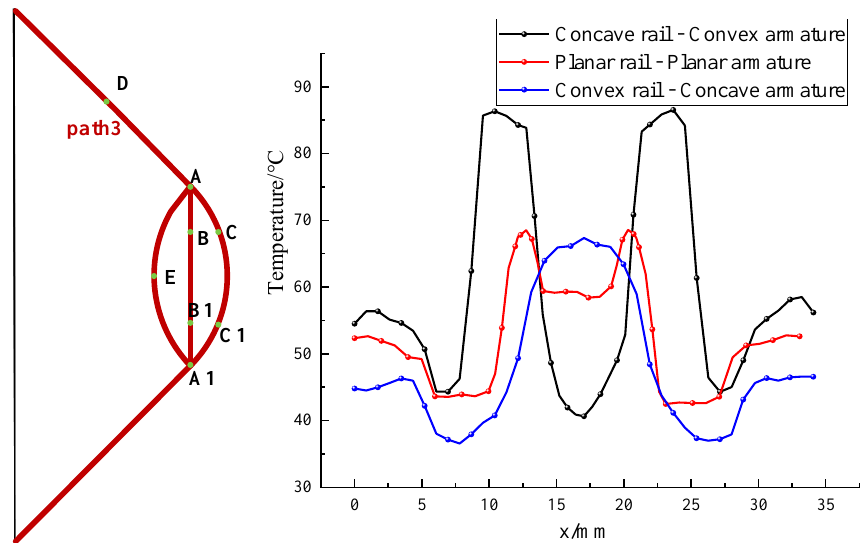
FIGURE 11. Schematic diagram of path 3 and temperature distribution From the above cross-sectional diagrams, it can be learned that the maximum temperatures at the trailing part of the rails of three configurations of electromagnetic launchers, namely, concave-rail-convex armature, planar- rail-plane armature and convex-rail-concave armature, are 61.52°C, 59.79°C and 52.11°C, respectively. The Joule heat on the orbits of the three configurations is mainly concentrated at the edge of the orbit, which is caused by the skinning effect and proximity effect of the current. The Joule heat on the contact surface of the pivot rail is more concentrated at the sides for the concave and planar rails, while it is more concentrated at the center of the contact surface of the pivot rail for the convex rail